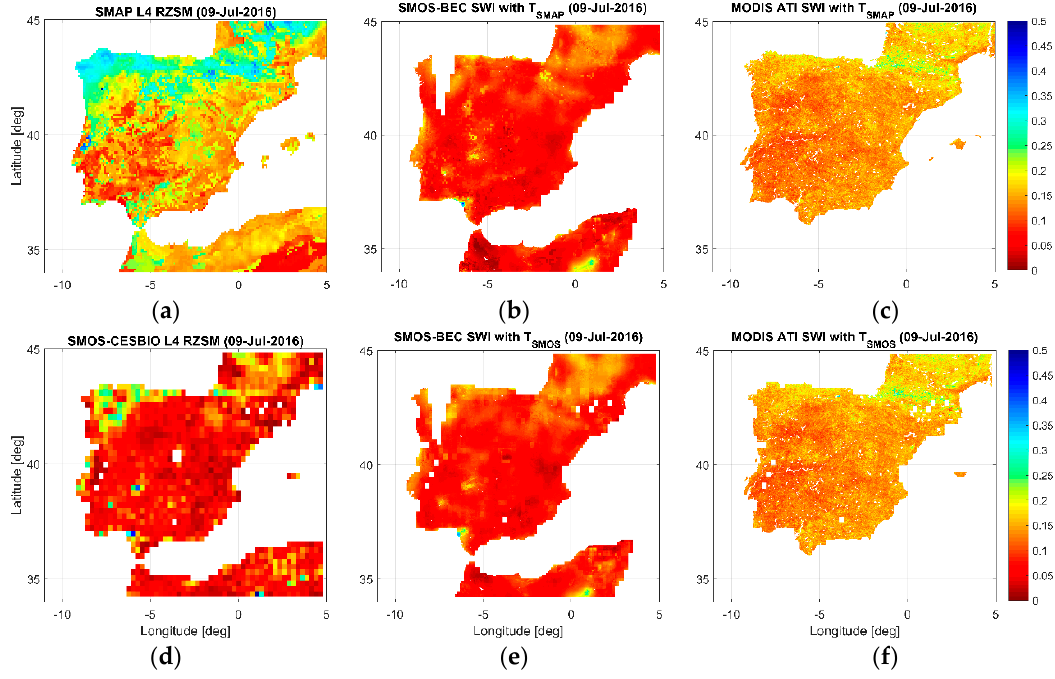
Figure 4. RZSM maps corresponding to a summer day (9 July 2016): ( a ) SMAP L4 RZSM; ( b ) SMOS-BEC SWI (T SMAP ); ( c ) MODIS ATI SWI (T SMAP ); ( d ) SMOS-CESBIO L4 RZSM; ( e ) SMOS-BEC SWI (T SMOS ); and ( f ) MODIS ATI SWI (T SMOS ).